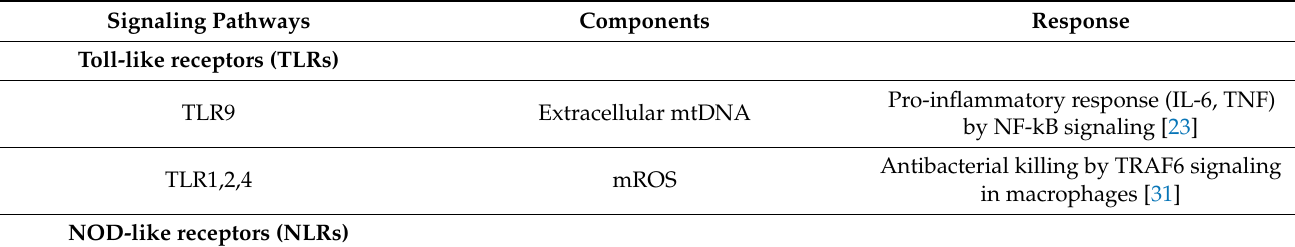
Table 1. Interplay between mitochondria and innate